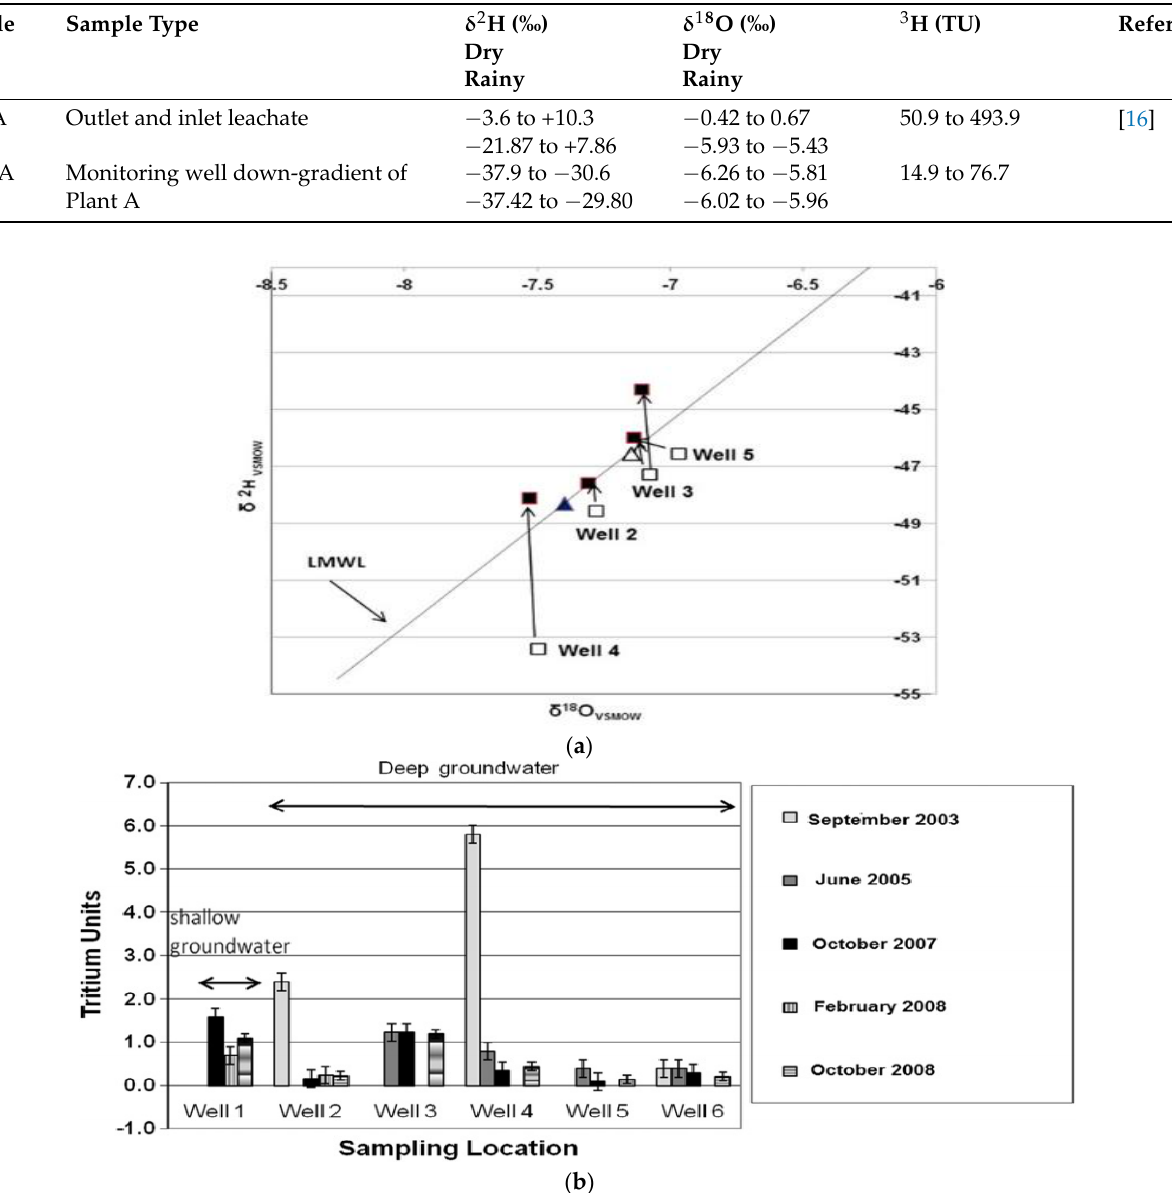
Figure 1. ( a ). Deuterium and oxygen 18 deviation from rainy to dry season [21]. ( b ) . Tritium trends from 2003 to 2008 of groundwater within the Rodriguez municipality, immediately downstream of the landfills